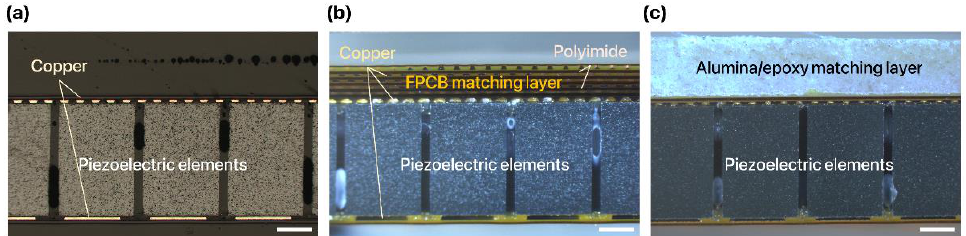
Figure 3. Cross-sectional optical images of 1D linear ultrasound transducer arrays ( a ) without acoustic matching layer, ( b ) with the FPCB matching layer, and ( c ) with the alumina/epoxy matching layer (scale bar: 200 µm).